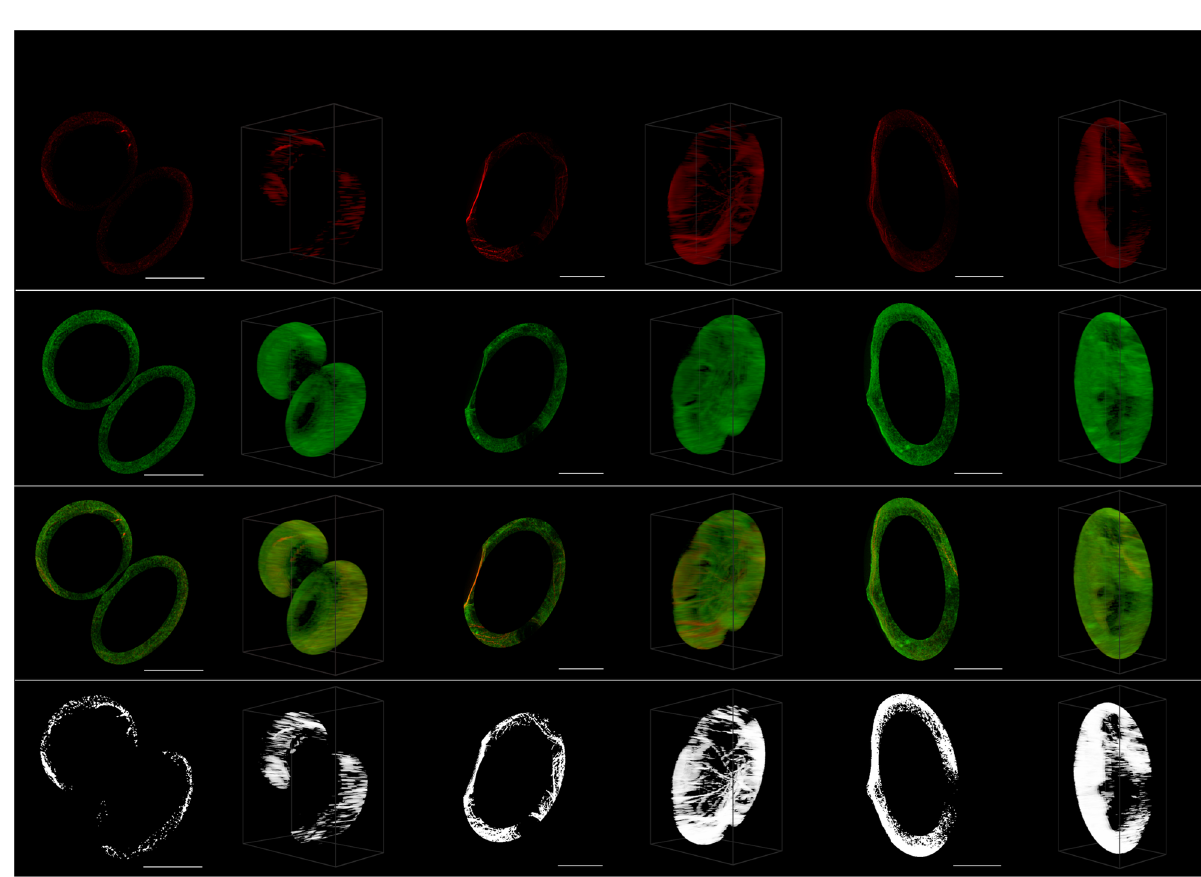
Fig 4. Ellipsoidal perinuclear region. Representative cells for each considered time ( t = 0, t = 6, t = 24) with the maximum intensity projection on the left and the 45˚ 3D view on the right. Shown from top to bottom are the acetylated α -tubulin (red), the Tau (green), the tubulin and Tau overlaid, and only the colocalized